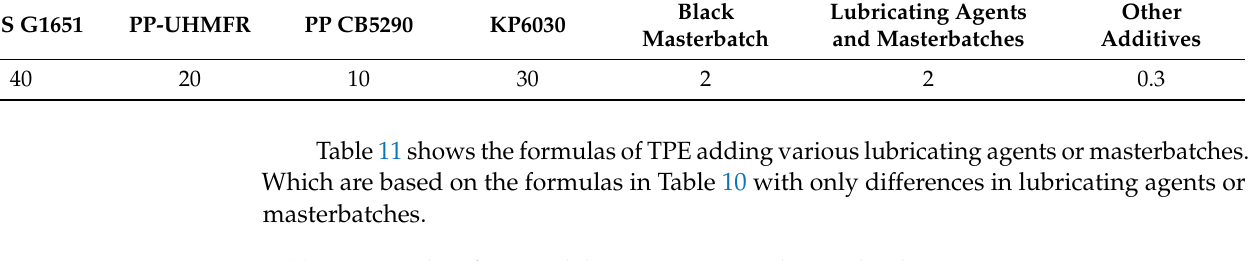
Table 10. Basic formulas of different lubricating agents and masterbatches.